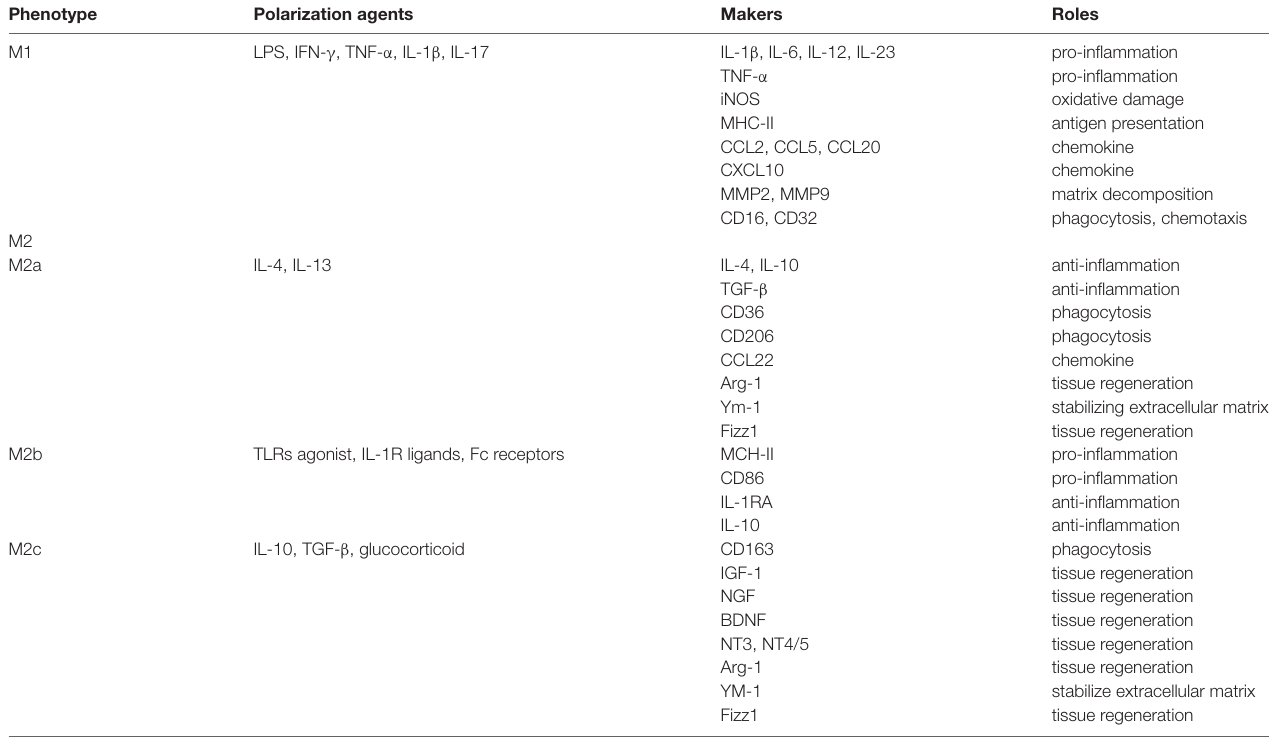
TABLE 1 | Particular information on microglia subtypes.